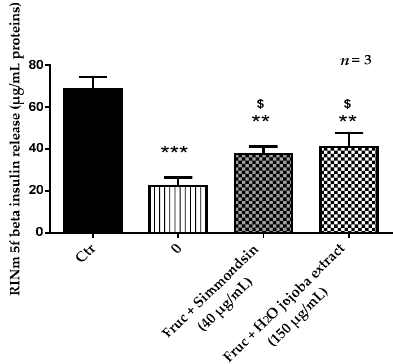
Figure 3. Effect of the aqueous jojoba seed extract and pure simmondsin on RINm5f beta cell static insulin release in the presence of fructose. Each value represents the mean ± standard error of the mean (SEM) of three independent experiments in triplicate. ** p < 0.01, *** p < 0.001, compared to untreated cells, $ p < 0.05, compared to fructose-treated cells.